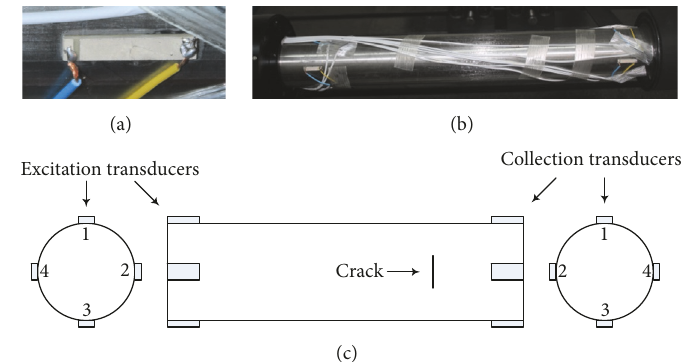
Figure 3: (a) Piezoelectric transducer, (b) photo of the arrangement of piezoelectric transducers array, and (c) sketch map of the arrangement of piezoelectric transducers array.